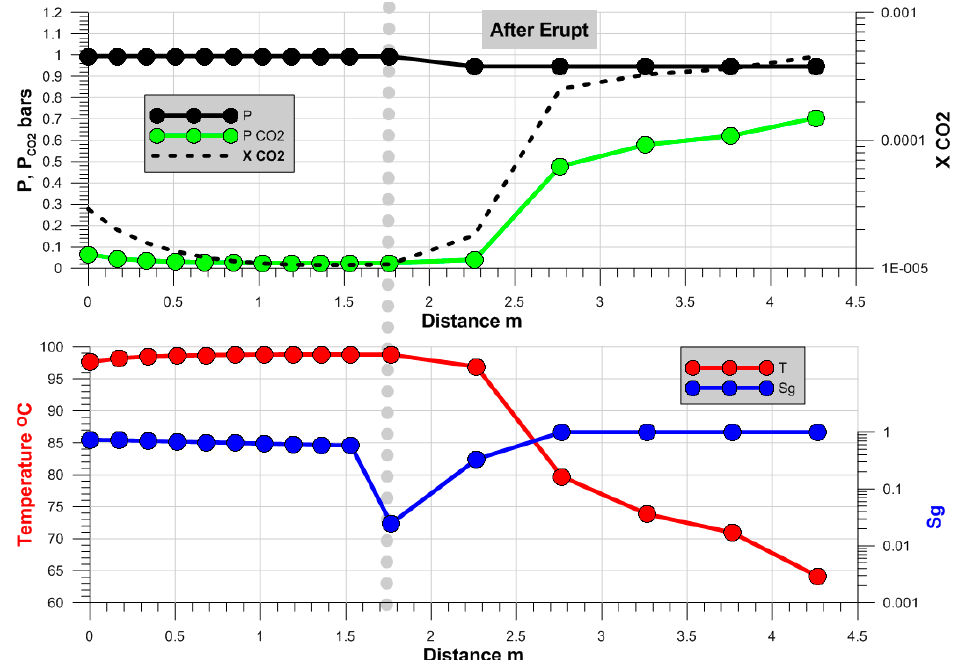
Figure 11. State after eruption (run #9B): model parameter distributions (temperature in °C, gas saturation Sg, pressure and partial CO 2 pressure P CO2 in bars, mass fraction of CO 2 in a liquid phase) along a streamline from hot water recharge element #11 to discharge element #56 of the model (see Figure 7 for model element name references). Vertical dotted line corresponds to the position of flow direction change from radial-horizontal to ascending-vertical.